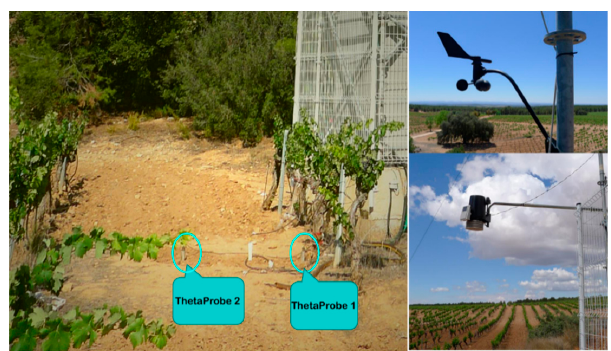
Figure 3. Soil moisture ThetaProbe sensors and Davis Vantage Pro2 Plus meteorological station.